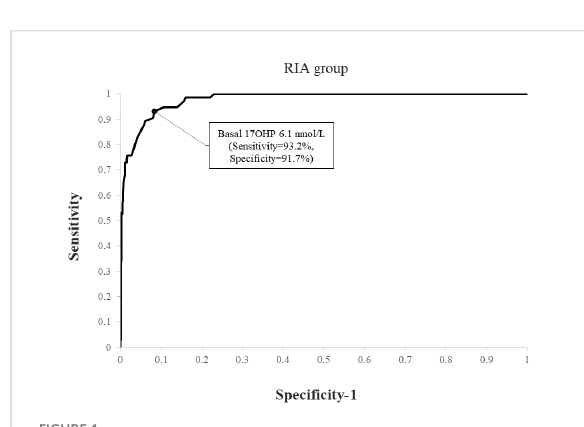
FIGURE 3 ROC curve analysis for determination of optimal basal 17OHP